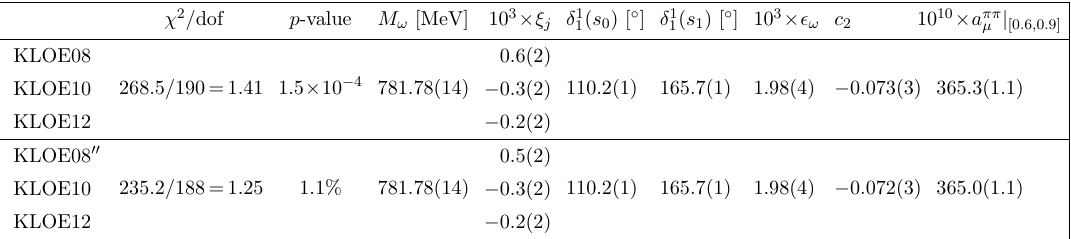
Table 6. The same as table 5 with individual energy rescalings for the KLOE experiments, but a common ! mass. In the set KLOE08 00 , two outliers have been deleted, see section